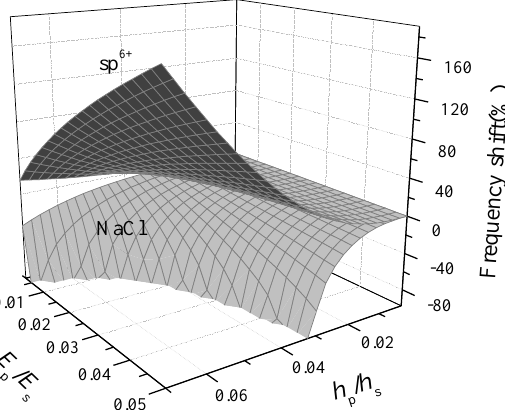
Figure 4. The first-order natural frequency shift of a hinged–hinged dsDNA-microbeam with the variation in the absolute value of film-to-substrate thickness ratio (i.e., r = | h p / h s |) and modulus ratio (i.e., g = | E p / E s |) in sp 6+ and NaCl solutions when the packing density η = 1.2 × 10 17 chain/m 2 .